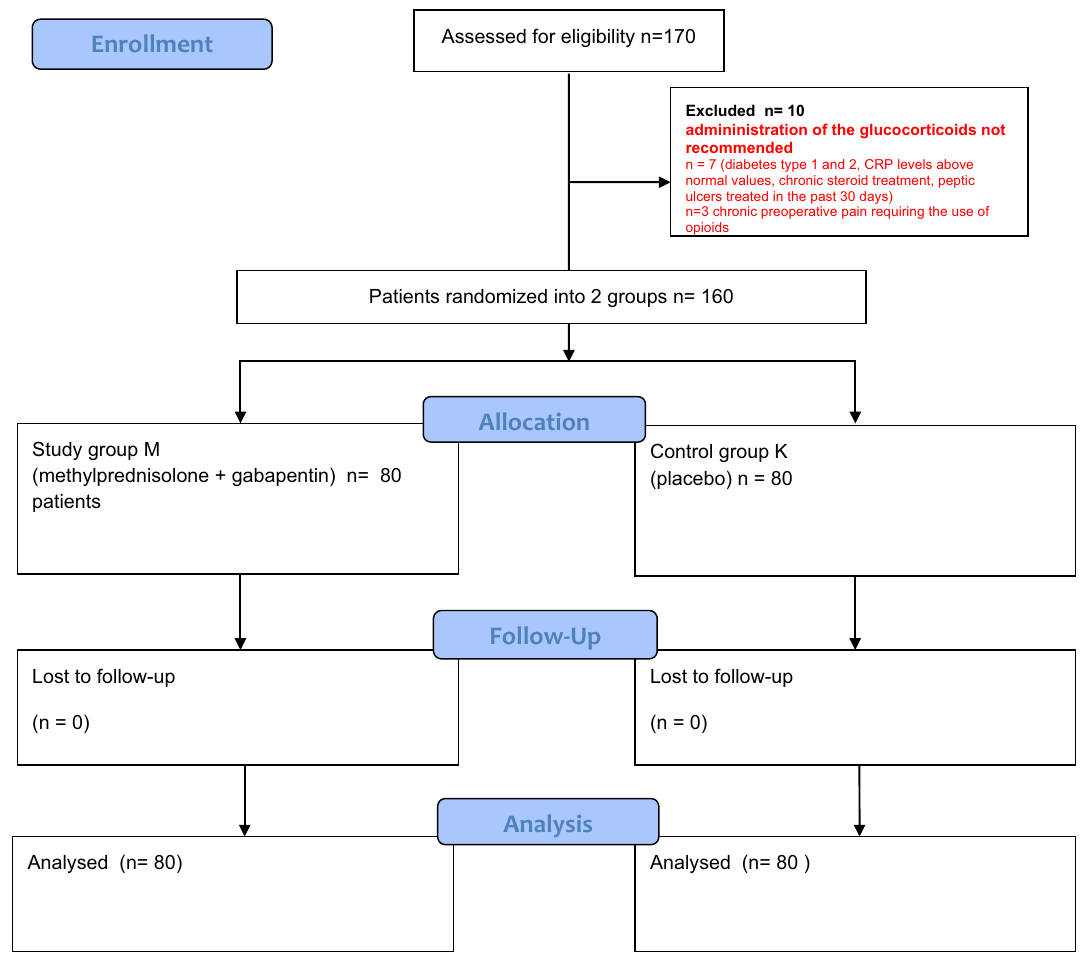
Figure 1. A schematic diagram showing the CONSORT flowchart. Patient selection and randomization methylprednisolone + gabapentin vs placebo as pre-emptive analgesia TKA (total knee